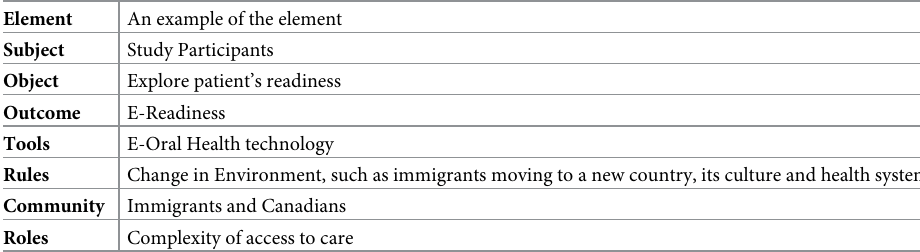
Table 2. Elements of Activity theory adapted to e-oral health technology.